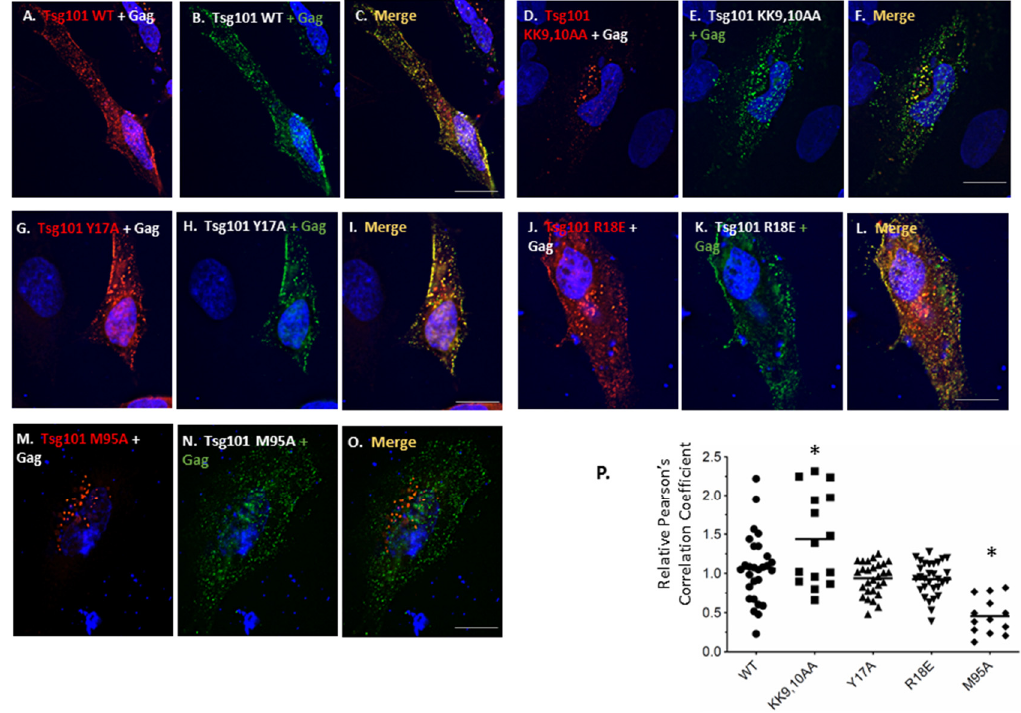
Figure 7. Recruitment from the cell interior requires tRNA-binding site. HIV-1 Gag-GFP was co-expressed with Tsg101 WT (panels A – C ), Tsg101 KK9,10AA (panels D – F ), Tsg101 Y17A (panels G – I ), Tsg101 R18E (panels J – L ), and Tsg101 M95A (panels M – O ) and examined for the ability to co-localize. Images were captured on an inverted fluorescence / di ff erential-interference contrast (dic) Zeiss Axiovert 200M fluorescence microscope. Scale bar equals 10 µ m. Scatter plot of relative Pearson’s correlation coe ffi cients assessment of co-localization is shown in panel P . Co-localization was determined for the entire co-transfected cell using NIH Image J, JACoP plugin software. Each Tsg101 mutant was scored relative to the average value for Tsg101 WT run in the same assay. By Student’s t -test analysis, KK9,10AA ( p < 0.05) and M95A ( p < 0.001) were significantly di ff erent from WT as indicated by the